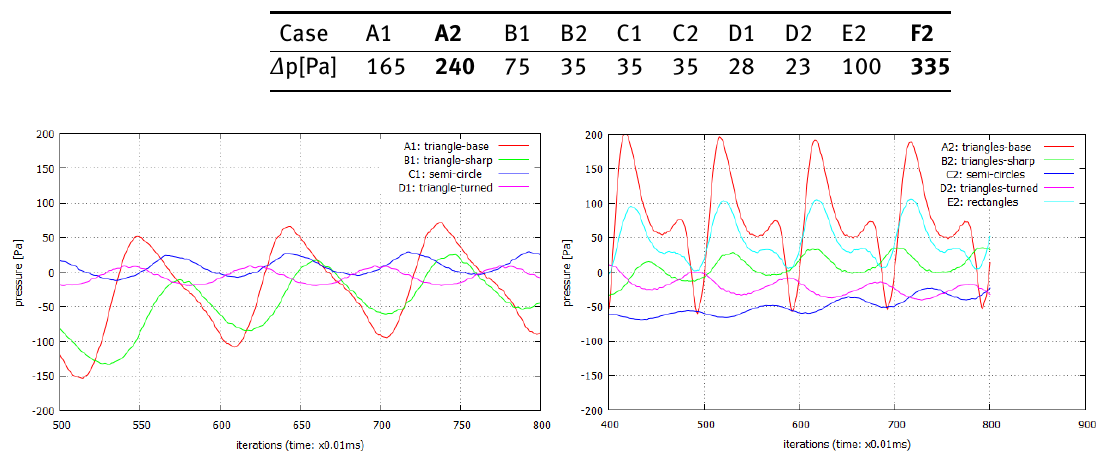
Figure 5: Left: Pressure evolution at the center S of the diaphragm for cases A1 and A2. Periodicity is established after about 5ms in physical time from the beginning of the calculation. Right: Pressure evolution at S for case A2: present study and from [4]. Table 2: Pressure amplitudes predicted at each case.